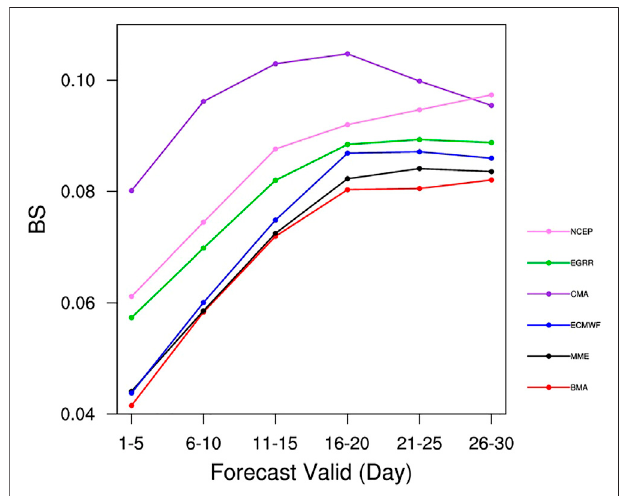
FIGURE 8 | Pattern correlation of the daily PHEI between the observed dataset and different model forecasts as a function of forecast lead days.